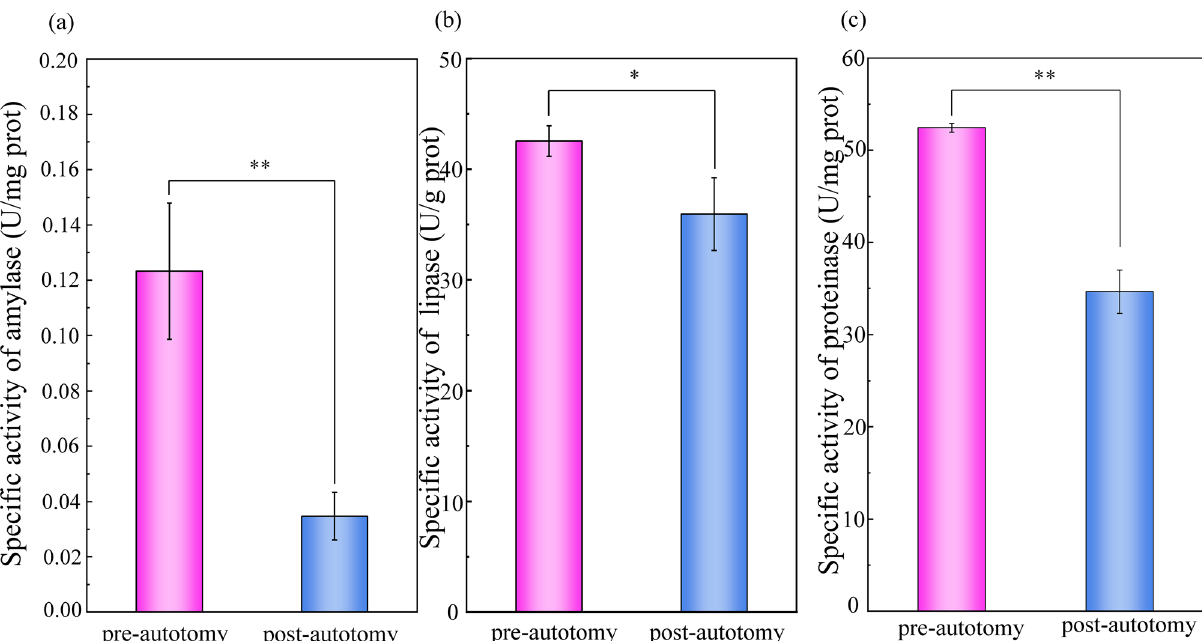
Figure 2. Effect of siphonal autotomy on digestive enzyme activities in Solen grandis . Data are expressed as mean ± SD. The asterisk (*) and (**) indicate a significant difference at P < 0.05 and P < 0.01,